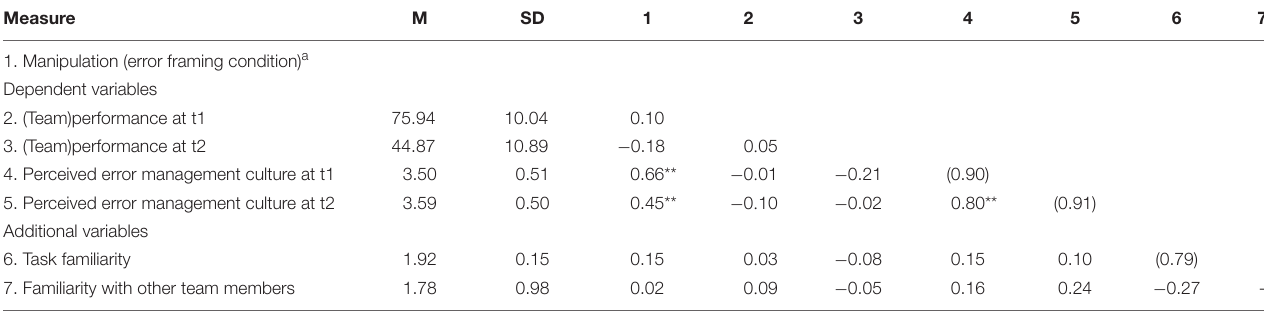
TABLE 1 | Means, standard deviations, and intercorrelations of Study 1 variables.